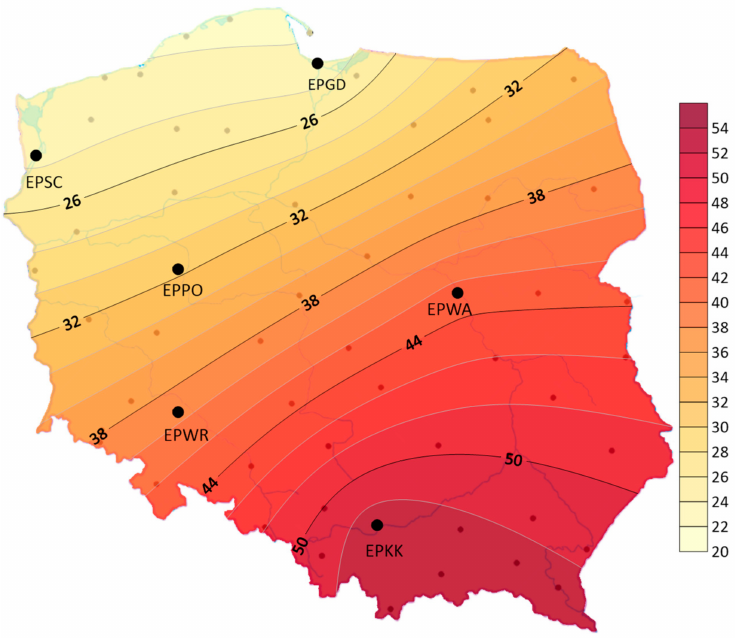
Figure 5. The average annual duration of storms in hours (1970–2018).